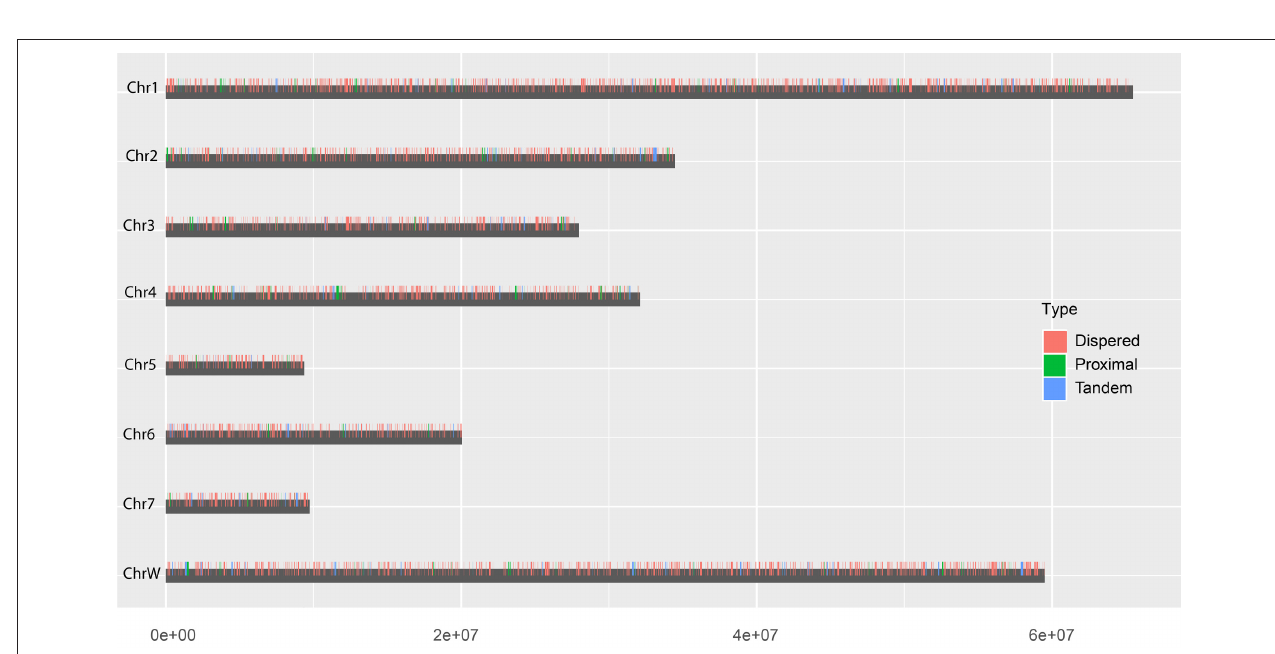
FIGURE 3 | Proportions of different gene duplication modes among the genome and locations for the duplicated genes on the sex chromosome. (A) The gene duplication modes determined by MCSCANX are shown. (B) The locations of the genes in the scaffold Smp.Chr_ZW are shown for all the genes (multicolored) as well as singleton (deep sky blue), dispersed (deep pink), proximal (cyan2) and tandem duplications (dark orange). The innermost circle represents the GC content and GC skew of the genomic regions.